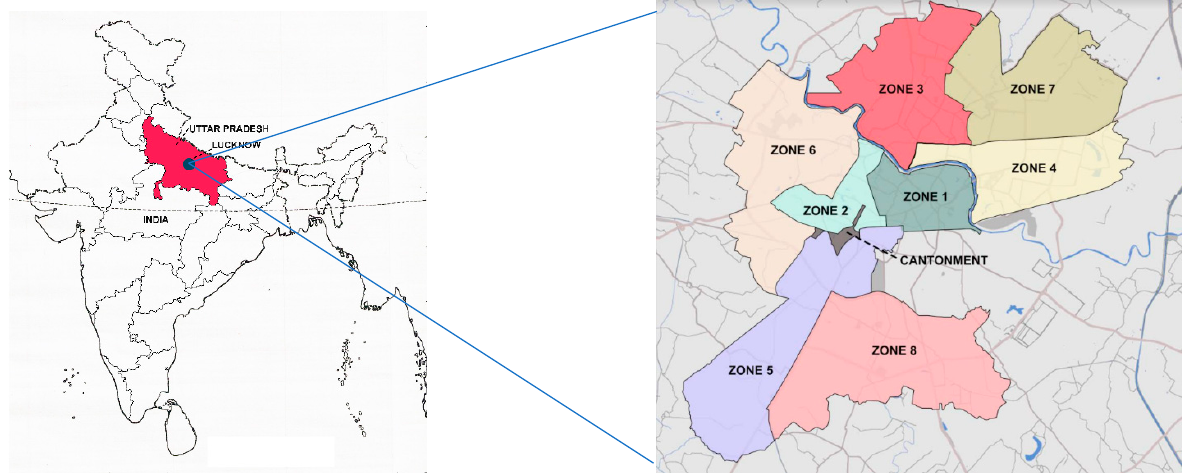
Figure 1. Location of Lucknow city and municipal administrative zones.